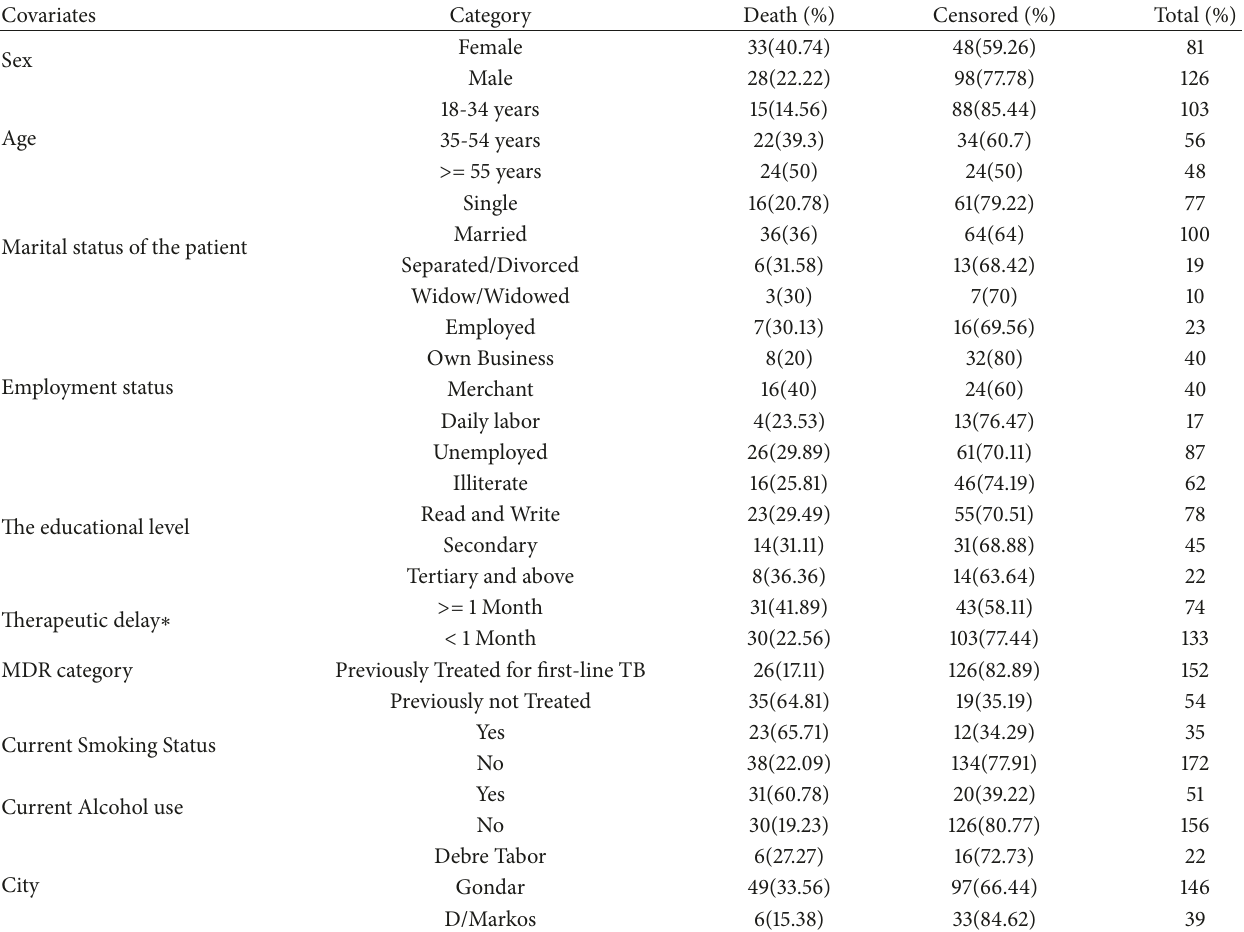
Table 1: Summary results of MDR–TB by different demographic